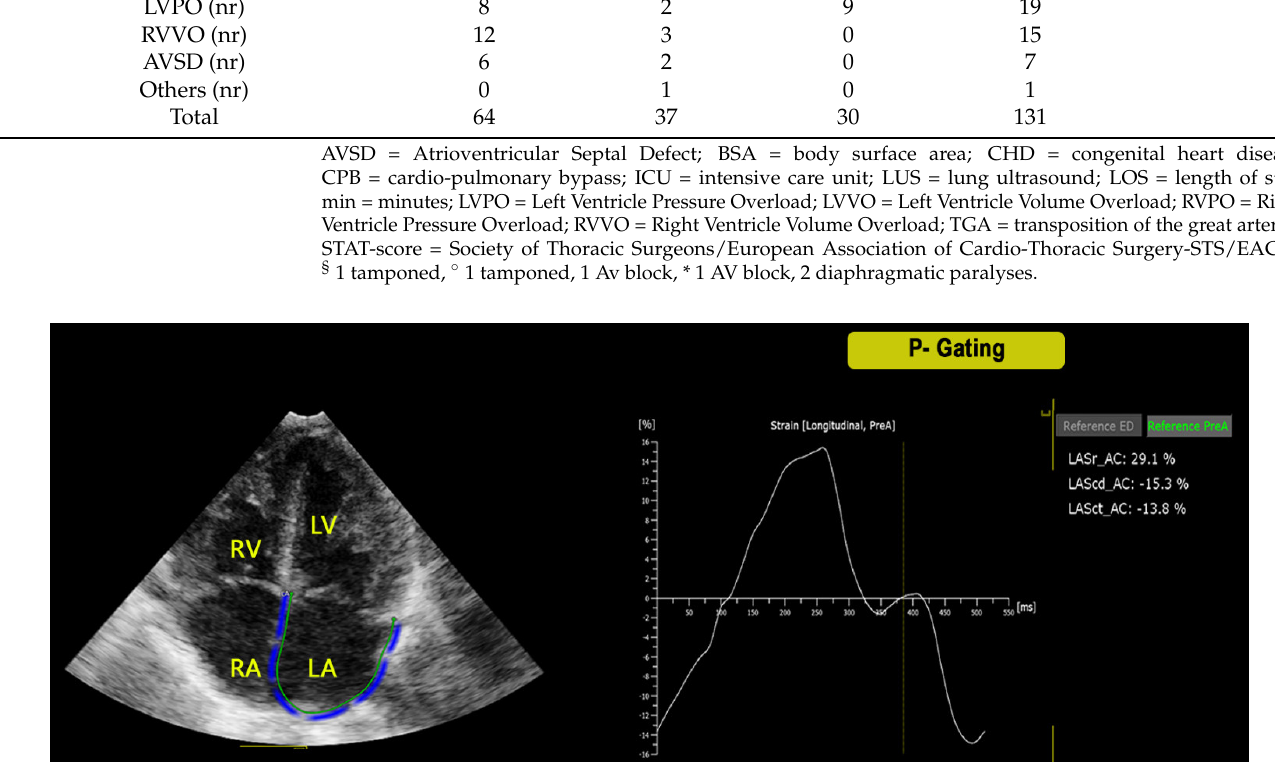
Figure 1. Left atrial ε analysis in the four-chamber view by using the atrial specific software for strain STE analysis with P-gating method. LA = Left atrium, LV = Left Ventricle, RA = Right Atrium, RV = Right Ventricle, Sr = strain reservoir, Sct = strain contractile, Scd = strain conduit. The ejection fraction was calculated by the biplane Simpson method. Approval for this study was obtained from the Local Ethics Committee (Comitato Etico Meyer no. 62/2016). Parents or legal guardians of all the children were informed and provided written consent